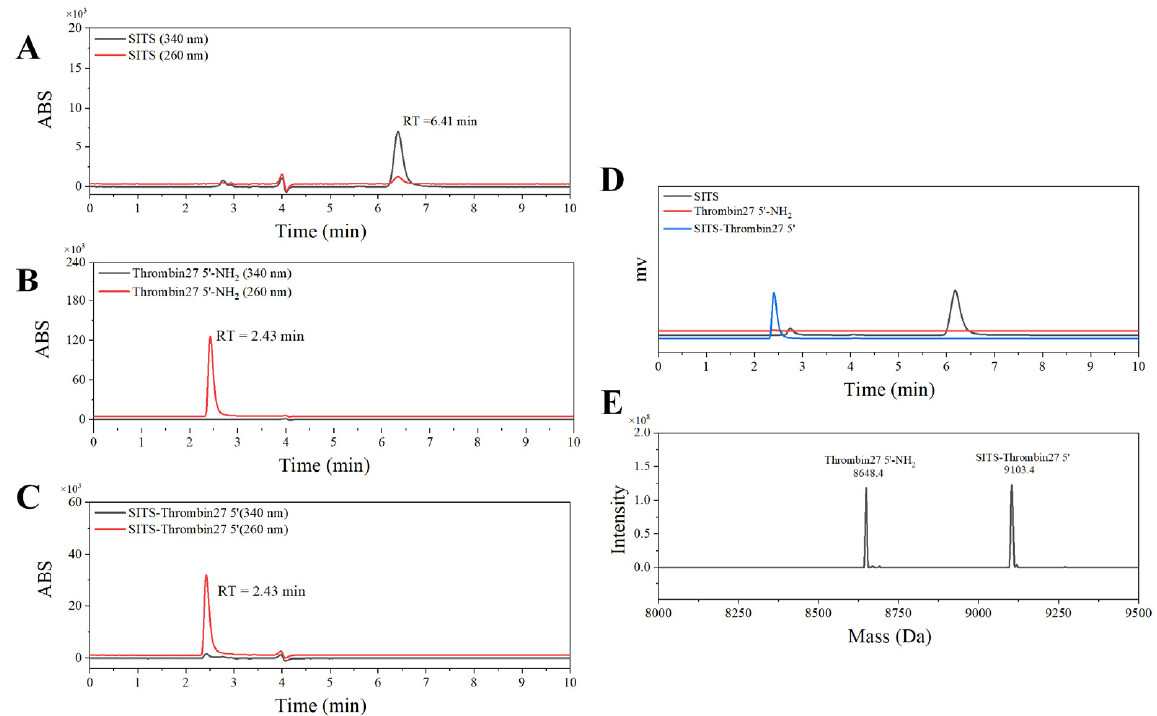
Figure 2. HPLC and MS characterization of SITS-Thrombin27 5 (cid:48) . HPLC–UV chromatography of SITS ( A ), Thrombin27 5 (cid:48) -NH 2 ( B ), and SITS-Thrombin27 5 (cid:48) conjugate ( C ). ( D ) HPLC–fluorescence chromatography (ex/em = 333 nm/426 nm) of SITS (black), Thrombin27 5 (cid:48) -NH 2 (red), and SITS-Thrombin27 5 (cid:48) (blue). ( E ) MS characterization of SITS-Thrombin27 5 (cid:48) conjugate.